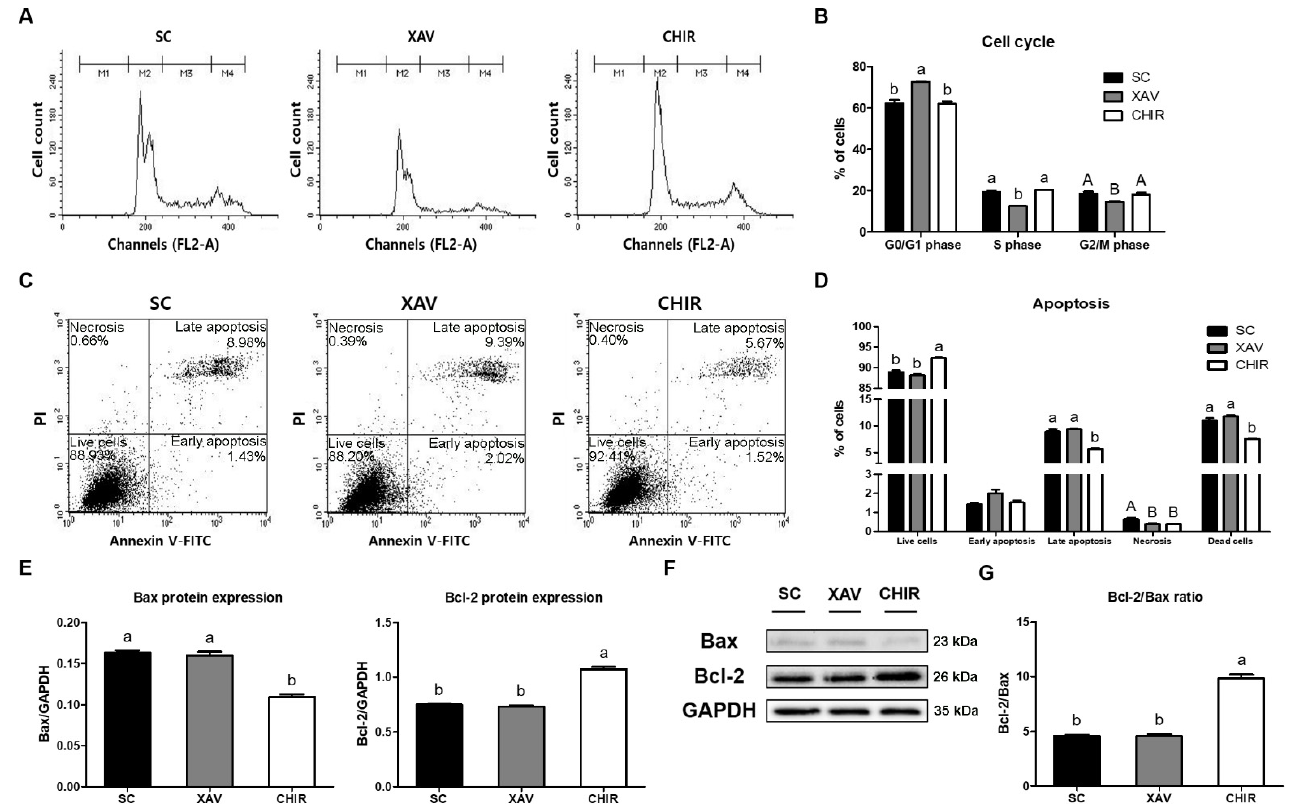
Figure 3. Comparison of cell cycle analysis and apoptosis detection of PMSCs by addition of Wnt signaling pathway regulators. ( A ) Schematic diagram of cell cycle analysis by flow cytometry. ( B ) Cell cycle assay results. ( C ) Dot plot of apoptotic cell death analysis by flow cytometry. ( D ) Apoptosis analysis results. ( E ) Quantitation of Bax and Bcl-2 protein levels relative to GAPDH. ( F ) Protein levels of Bax and Bcl-2 in PMSCs. ( G ) The ratio of Bcl-2/Bax. Dead cells = cells during early apoptosis + late apoptosis + necrosis. Values are presented as mean ± SE. a,b Different letters represent statistically significant differences among treatment groups ( p < 0.01). A,B Different letters represent statistically significant differences among treatment groups ( p < 0.05). Full-length blots are presented in Supplementary Figure